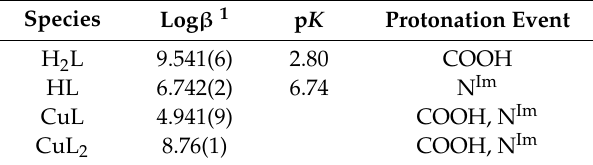
Table 1. Protonation constants for cis -UCA (L) and logarithmic complex formation constants for the interaction of Cu(II) ions with cis -UCA, together with the ascribed protonation events. Species Log β 1 p K Protonation Event